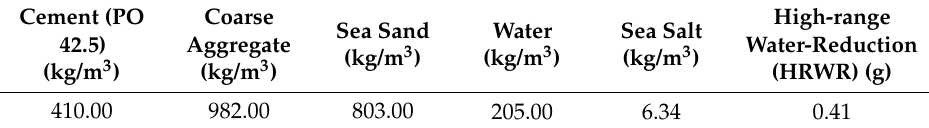
Table 1. Mix proportion of sea sand and seawater concrete (SSC) on site.